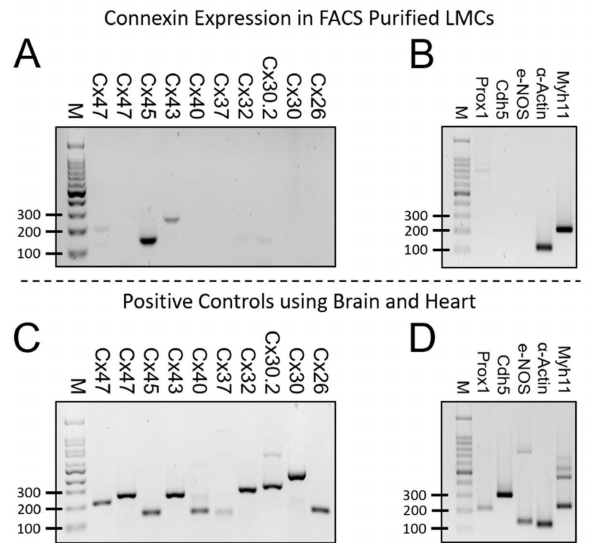
Figure 6. Connexin isoform mRNA expression (RT-PCR) on FACS purified LMCs from control mice: ( A ) mRNA expression for various Cx isoforms in FACS-purified LMCs, showing expression of Cx45 and to a lesser extent Cx43 and Cx47; ( B ) Assessment of LMC purity by determining mRNA expression of markers commonly observed in LMCs and LECs. Purified LMCs show strong α -actin and Myh11 message, while the LEC markers Prox1, Cdh5, and e-NOS are undetectable; and positive control tests using ( C ) brain or ( D ) heart tissues, for the gene targets shown in panels A and B. Representative of 5 gels on 5 di ff erent samples /